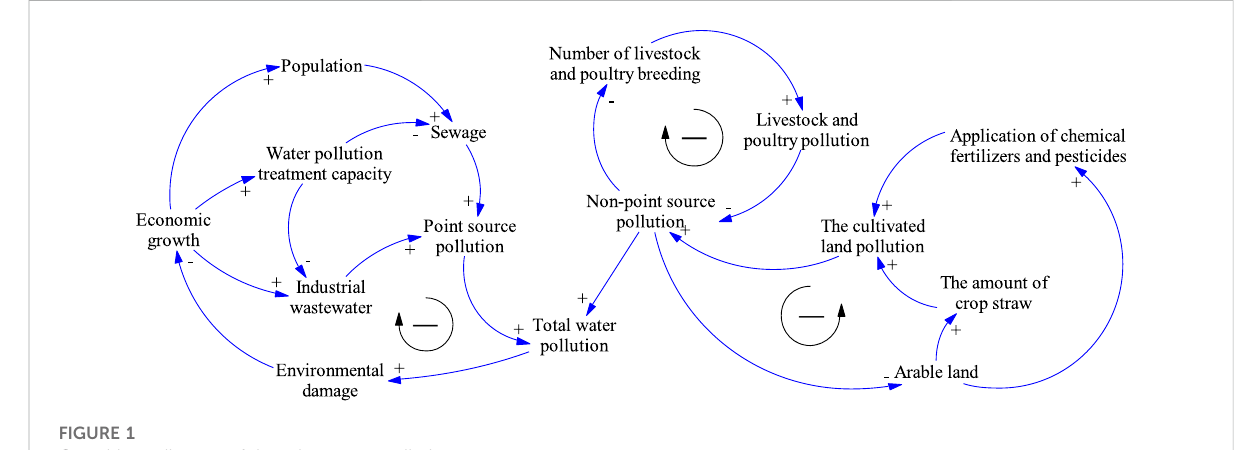
Causal loop diagram of the urban water pollution